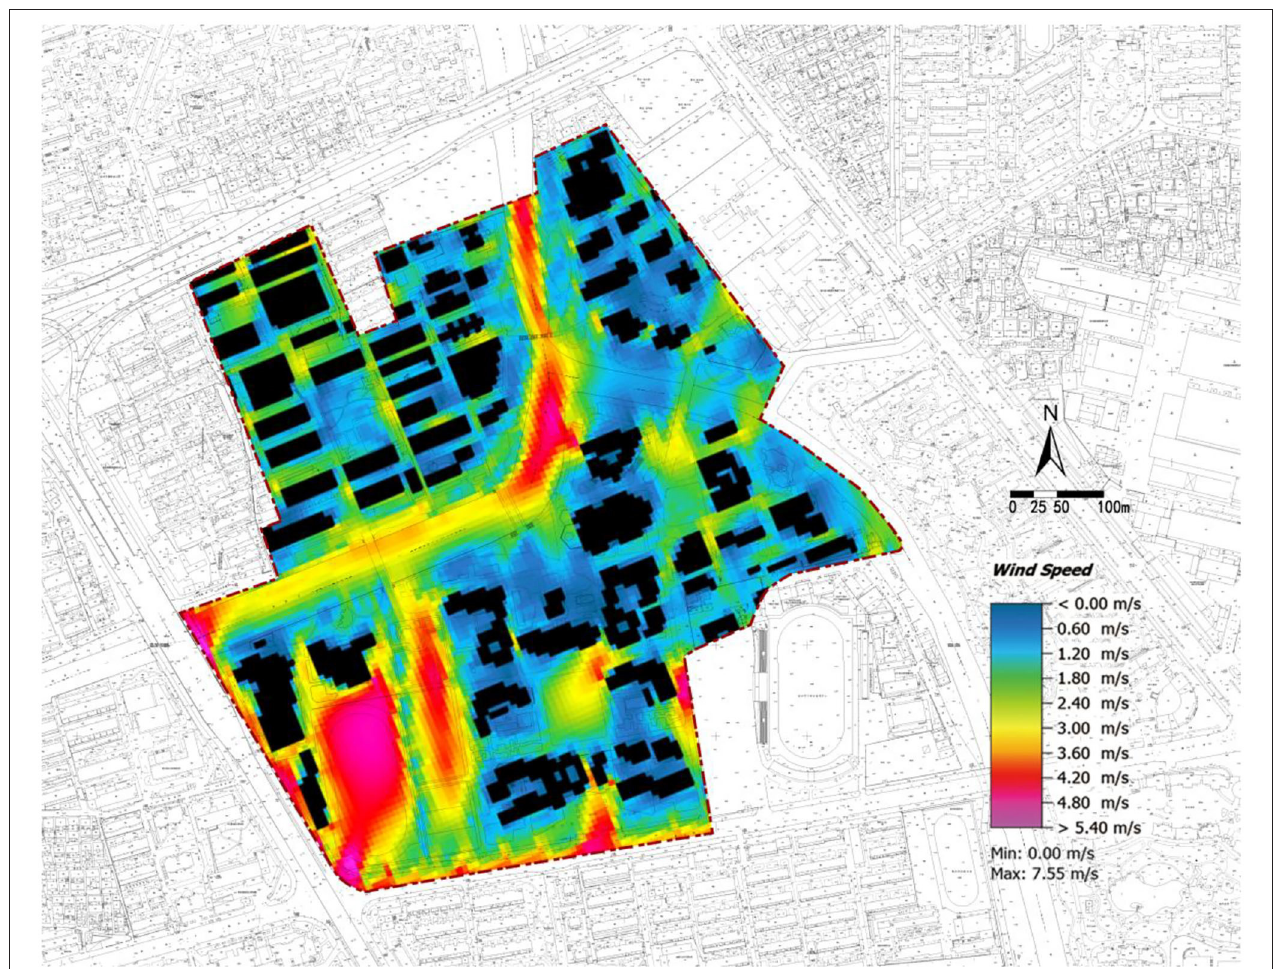
FIGURE 6 | Zhaohui Campus of Zhejiang University of Technology: Numerical simulation diagram of wind speed at 14:00.